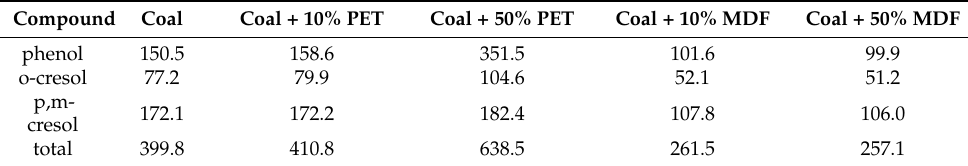
Table 3. Emission factors of phenols (mg/h).